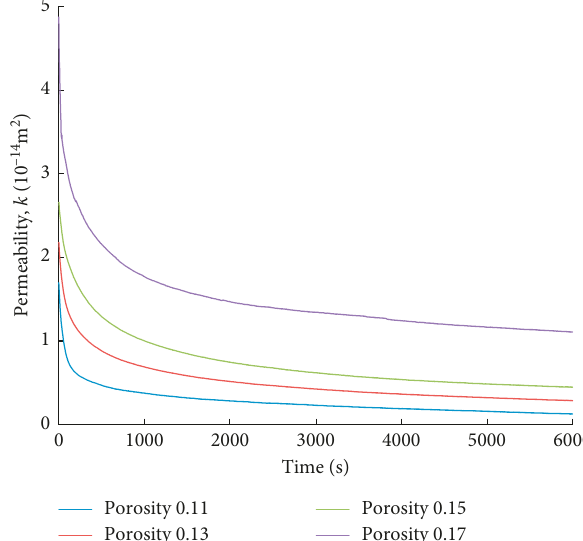
Figure 6: Relationship of seepage instability duration and initial porosity.